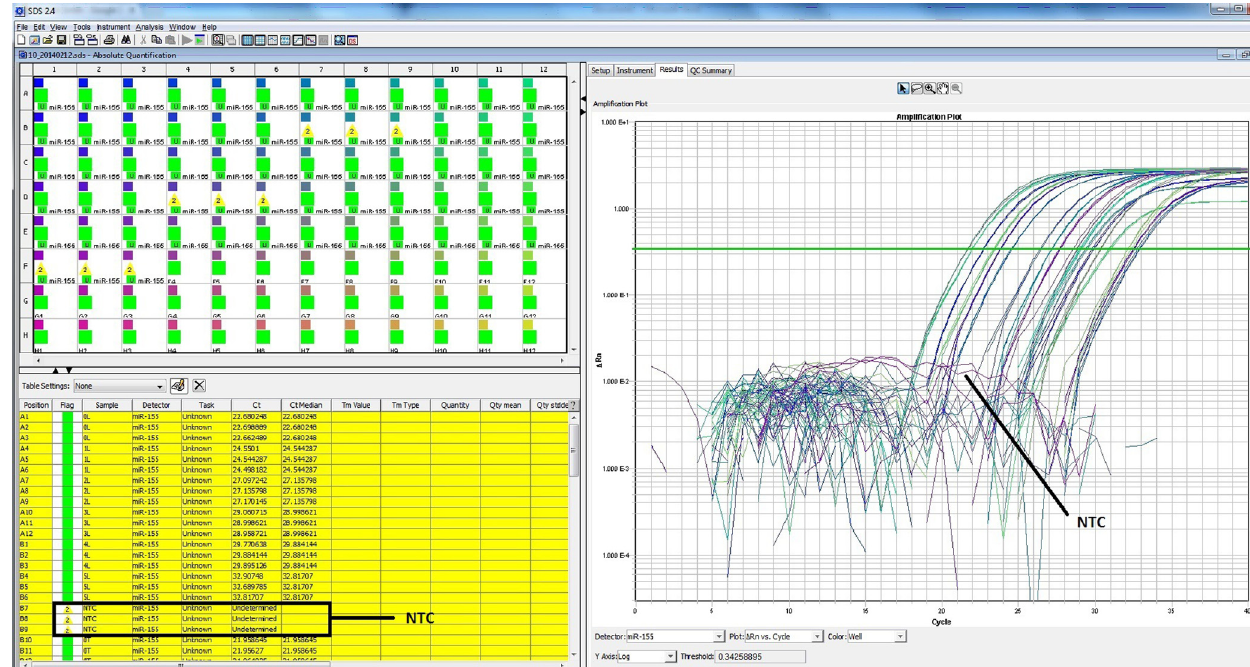
Supplementary Figure 1. RT-qPCR amplification curves. There was no amplification observed in the no-template control (NTC)